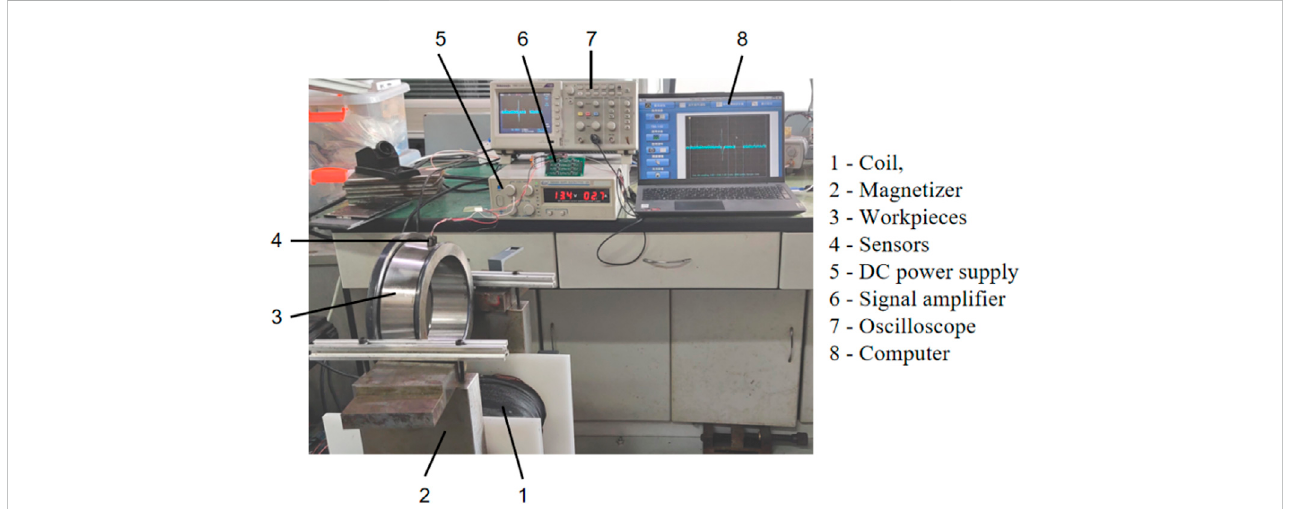
FIGURE 12 Experimental platform for axial detection of the bearing cracks.